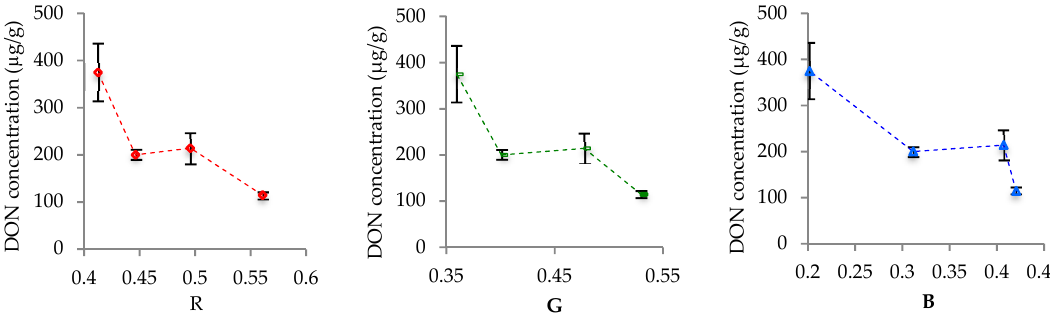
Figure 6. Relationship between color variation and DON concentration at a w = 0.99.